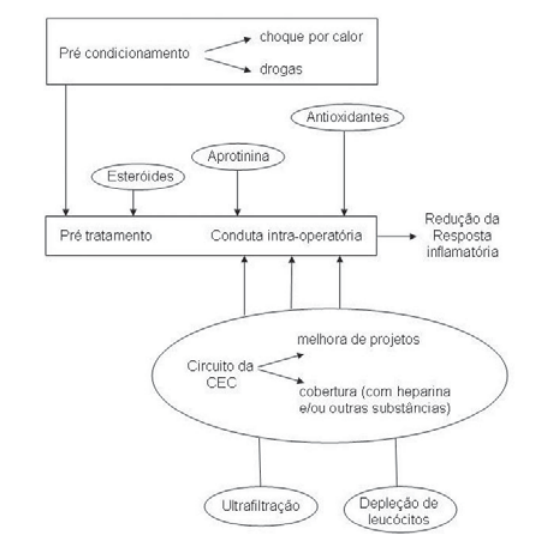
Fig. 4 - Possíveis estratégias terapêuticas para reduzir a resposta inflamatória durante a circulação extracorpórea (Adaptado de Wan et al.